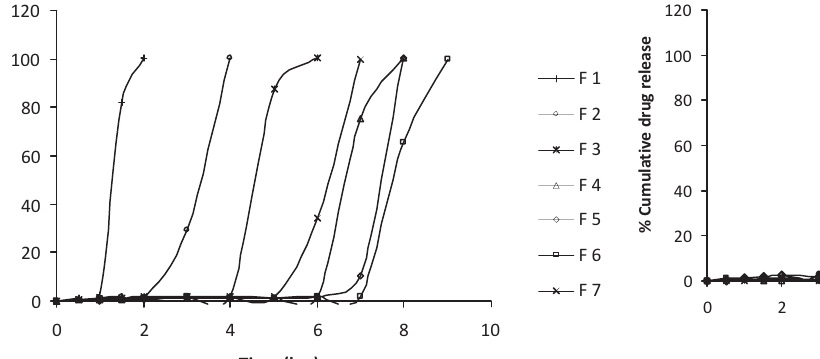
FIGURE 3 - Dissolution Profiles of CCT using PEO WSR 1105 as coating polymer P 1-7. (mean±s.d., n=3).